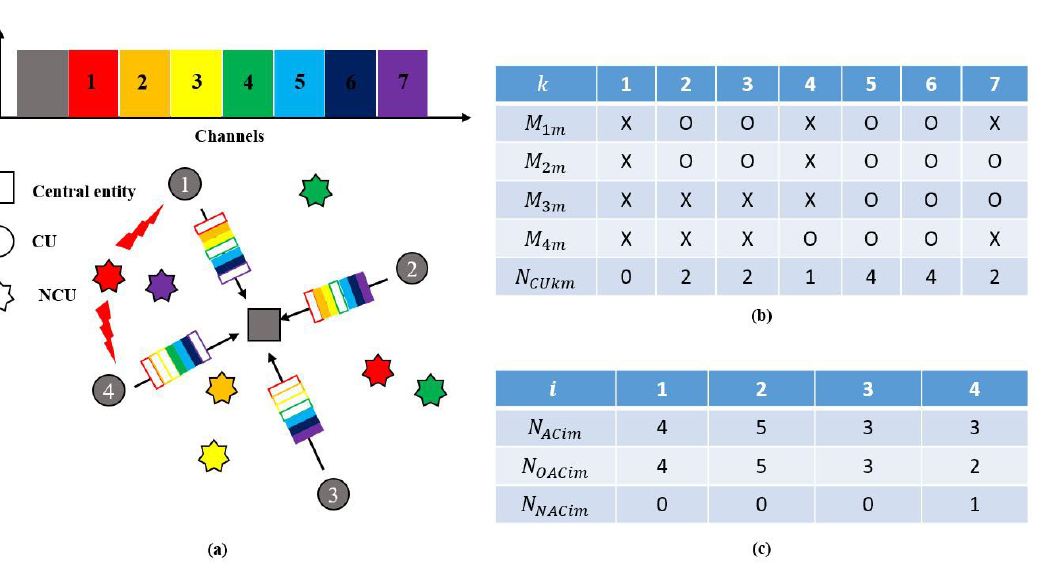
and ; ( c ) the results of , 𝑀𝑀 𝑖𝑖𝑚𝑚 𝑁𝑁 𝑁𝑁𝑁𝑁𝐶𝐶𝑚𝑚𝑚𝑚 𝑁𝑁 𝑀𝑀𝑁𝑁𝑖𝑖𝑚𝑚